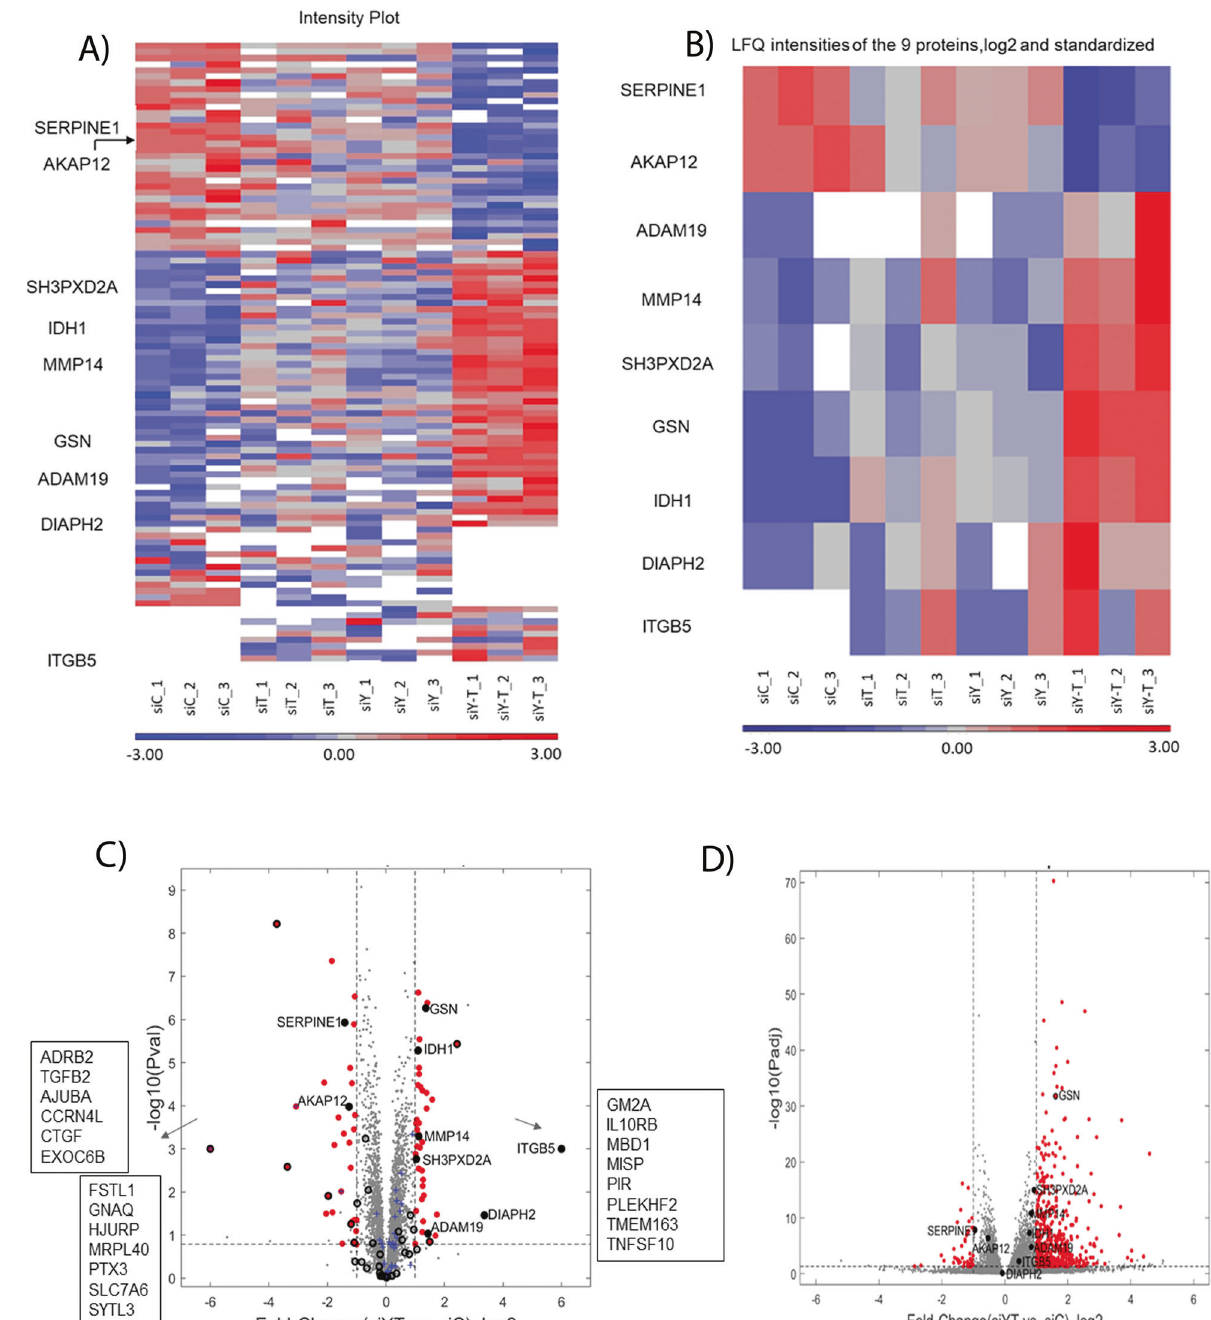
Fig. 6 Protein pro fi ling results after knockdown of YAP, TAZ or both in MDA-MB-21 cell line. A A heatmap of the expression levels of 122 differential proteins obtained from the proteomic pro fi ling for each treatment condition with three independent sets of experiments are shown. LFQ intensities were log2 transformed and standardized. Missing values are shown in white. B A heatmap of the nine invadopodia- related proteins that were differentially expressed proteins after co-knockdown of YAP + TAZ. C Volcano plot from protein pro fi ling results showing signi fi cantly differential proteins marked as red dots indicating up-regulation of proteins such as ADAM19, DIAPH2, GSN, IDH1, ITGB5, MMP14 (MT1-MMP), SH3PXD2A on the right side whereas downregulation of proteins AKAP12 and SERPINE1 on the left side. Proteins that changed qualitatively in the analysis are listed in boxes Blue crosses indicate hippo-signaling pathway proteins detected from the protein pro fi ling results. Black empty circles denote proteins that were detected in the single knockdown of either YAP or TAZ. D Volcano plot for the genes obtained from the transcriptome analysis. Red dots indicate differentially expressed genes. invadopodia-negative cell lines, e.g., by changing the environmental conspicuous invadopodia, while cell lines derived, for example, from conditions (e.g., EGF stimulation); see [49], or the cells ’ signaling ovarian adenocarcinomas or breast adenocarcinoma were mostly machinery (e.g., knockdown of YAP and TAZ, inspired by the present invadopodia negative (4/4 and 3/4, respectively). Further attempts to study) failed to turn-on invadopodia formation in these cells, induce invadopodia formation and matrix degradation in the